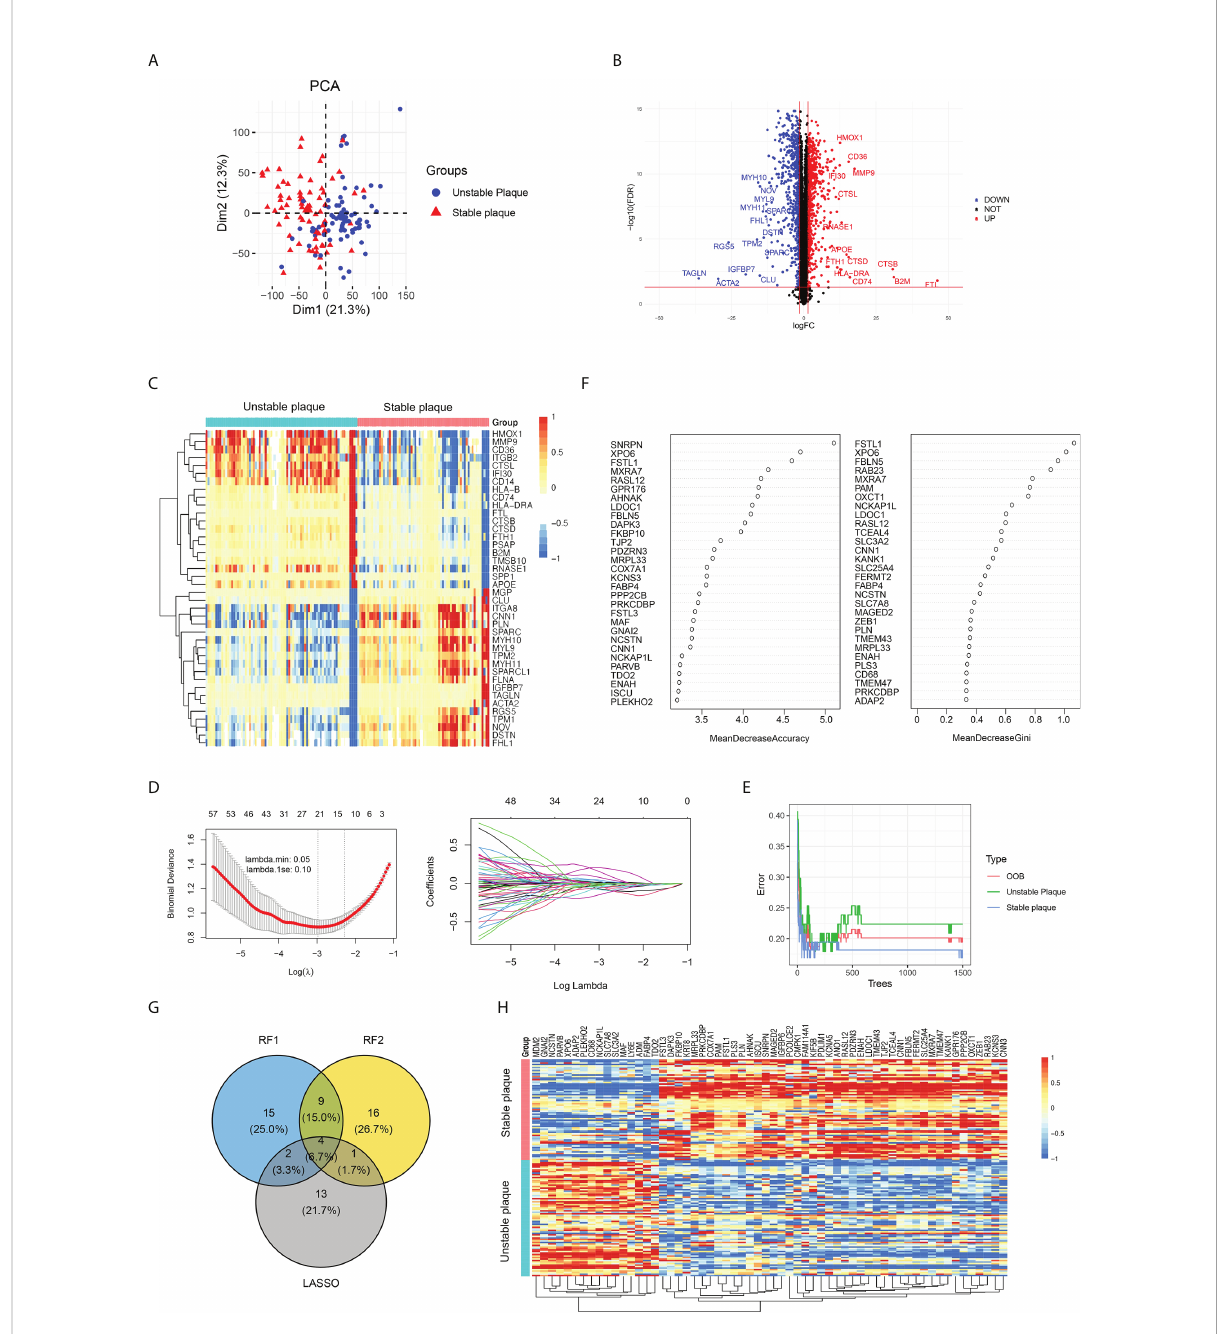
FIGURE 3 Identi fi cation of key differentially expressed genes (DEGs) between unstable and stable plaques. (A) PCA plot of gene expression pro fi le, colored by unstable and stable plaque groups. (B) Volcano map of DEGs in unstable plagues compared to stable plagues. The signi fi cantly upregulated DEGs (FDR < 0.05 and a log2FC>1.5) were labeled in red, and the signi fi cantly downregulated DEGs (FDR < 0.05 and a log2FC< − 1.5) were labeled in blue. (C) The expression of top 40 DEGs was visualized by heatmap. (D) LASSO regression was conducted to analyze the DEGs in unstable plague and stable plague groups. (E, F) RandomForest was conducted to analyze the DEGs in unstable plague and stable plague groups. (G) Venn diagram was conducted to obtain the intersection of the key DEGs screened by the two methods. (H) Expression of key DEGs was visualized by